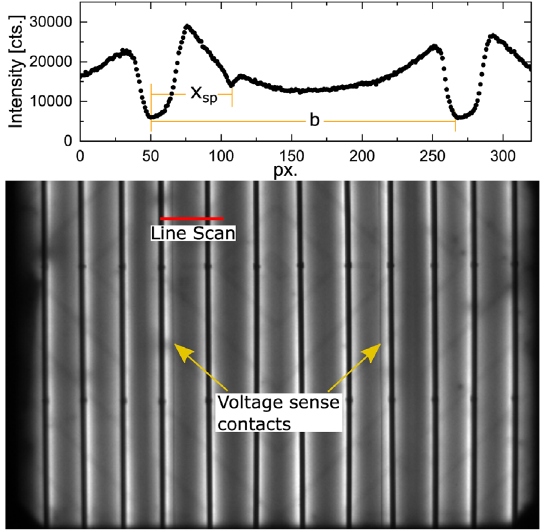
Fig. 4. EL picture of a HJT solar cell without front metallization contact with 12 bars and 2 voltage sense contacts. A line scan is performed to determine the distance b between two current contacts and x sp of the voltage sense to a current